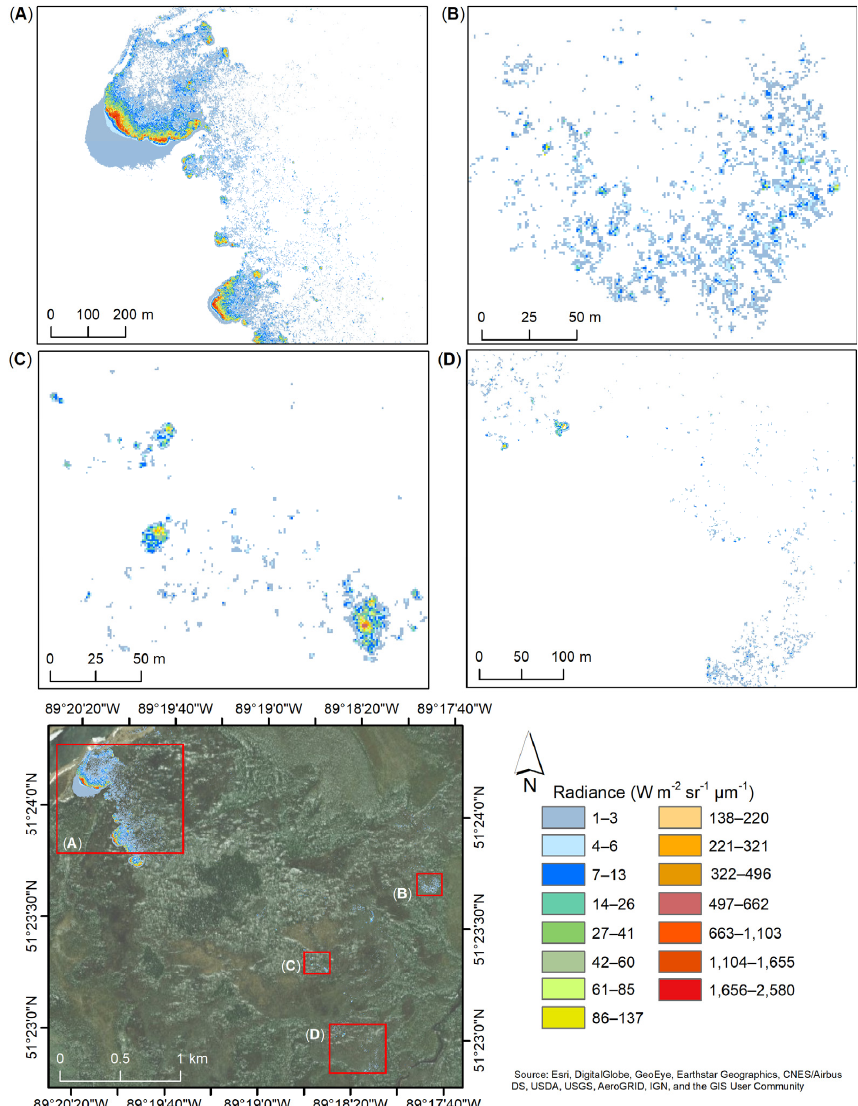
Figure 13. Radiance (Wm − 2 sr − 1 µm − 1 ) captured during the nighttime flight, F-04, acquired on 3 August 2017, over four different area ( A – D ) of the SLK-37 site. Radiance of the 1.4 ms, 0.3 ms, 0.04 ms, and 0.0021 ms integration times superimposed based on the set thresholds (Section 3.3). Radiance below 1 Wm − 2 sr − 1 µm − 1 (white) not displayed.